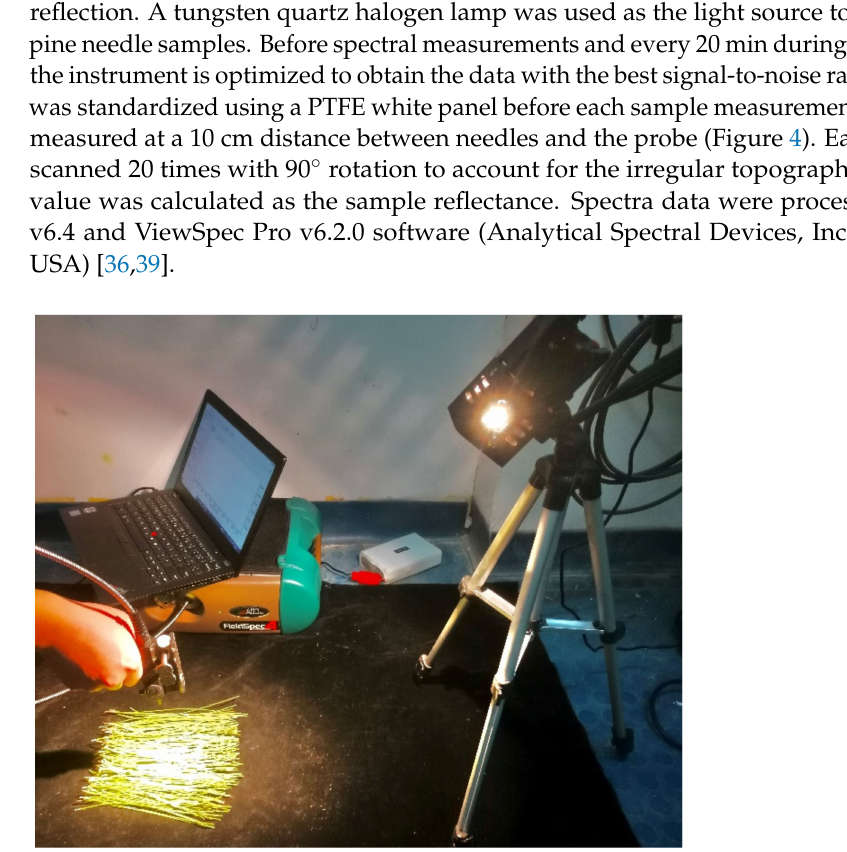
Figure 4. Spectral data acquisition